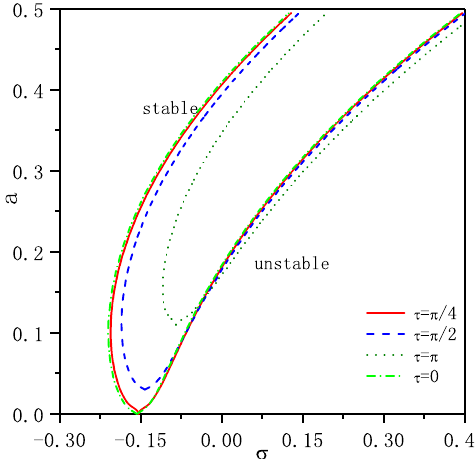
Figure 15. Amplitude of the response as a function of amplitude of the excitation for several detunings with acceleration feedback.